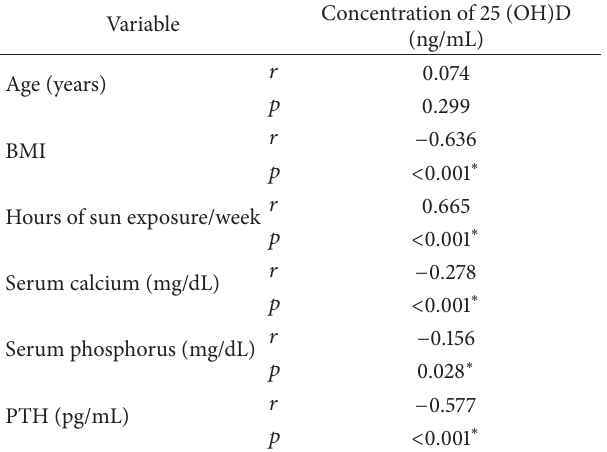
Table 2: Correlation between serum vitamin D (25(OH)D) concen- tration and different predictive